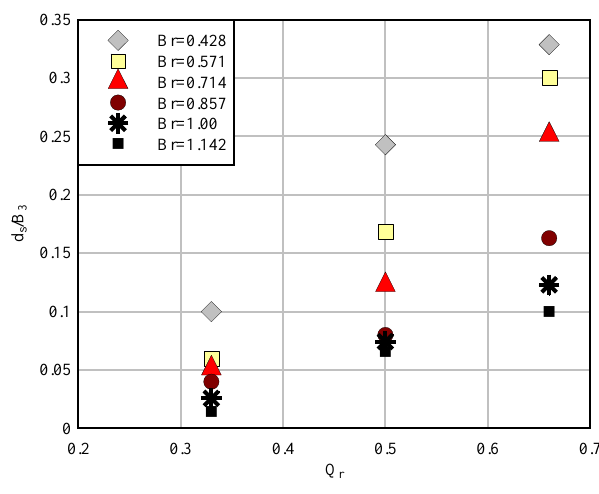
Figure 13. Q r vs. ds / B 3 for different B r .